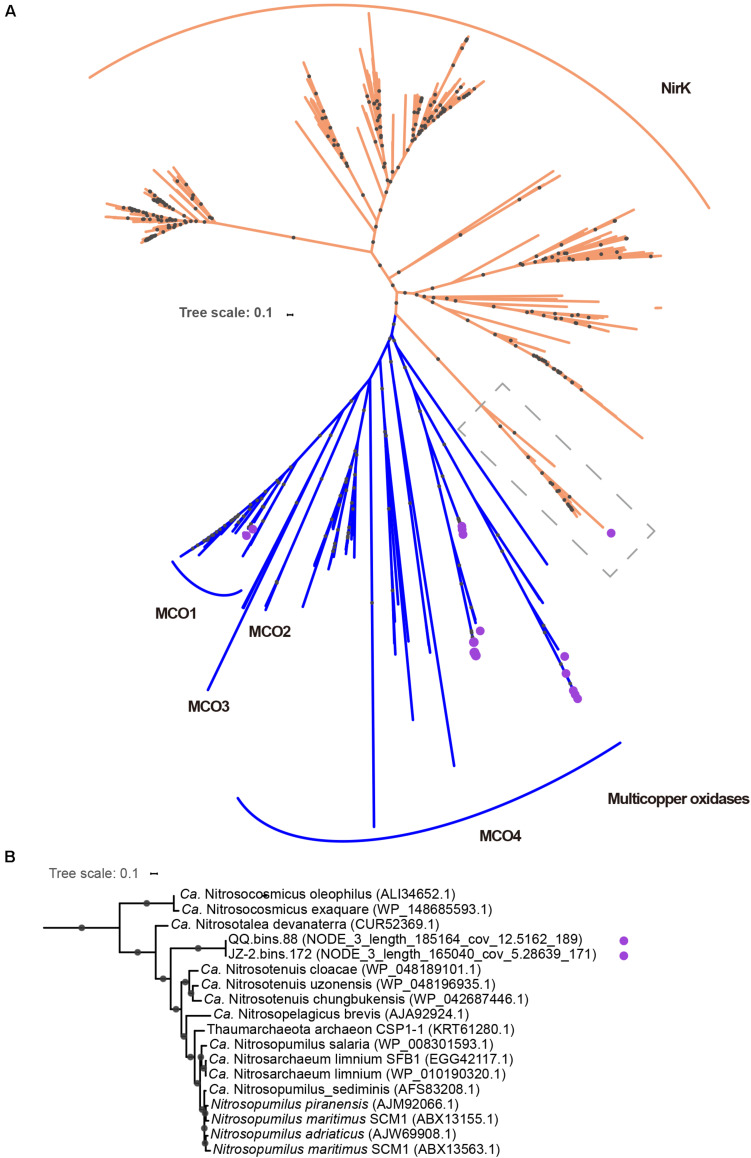
(A) The full unrooted tree for NirK and multicopper oxidases (MCOs) included sequences retrieved from our study (with purple circles), references from Decleyre et al. (2016) and Kerou et al. (2016). The full tree was constructed from an alignment of 406 sequences. Sequences encoded by nirK gene are indicated in orange, and multicopper oxidase genes in blue. Dashed boxes in gray contained nirK gene identified in our study (“Ca. Nitrosocladaceae”) and from other Thaumarchaeota genomes. Clades of MCOs were based on phylogenetic trees in Kerou et al. (2016). (B) The expanded version of the subsection in the dashed box. Nodes with ultrafast boot strap ≥95% (50%) are indicated as solid (hollow) circles and the scale bar indicates 10% sequence divergence.